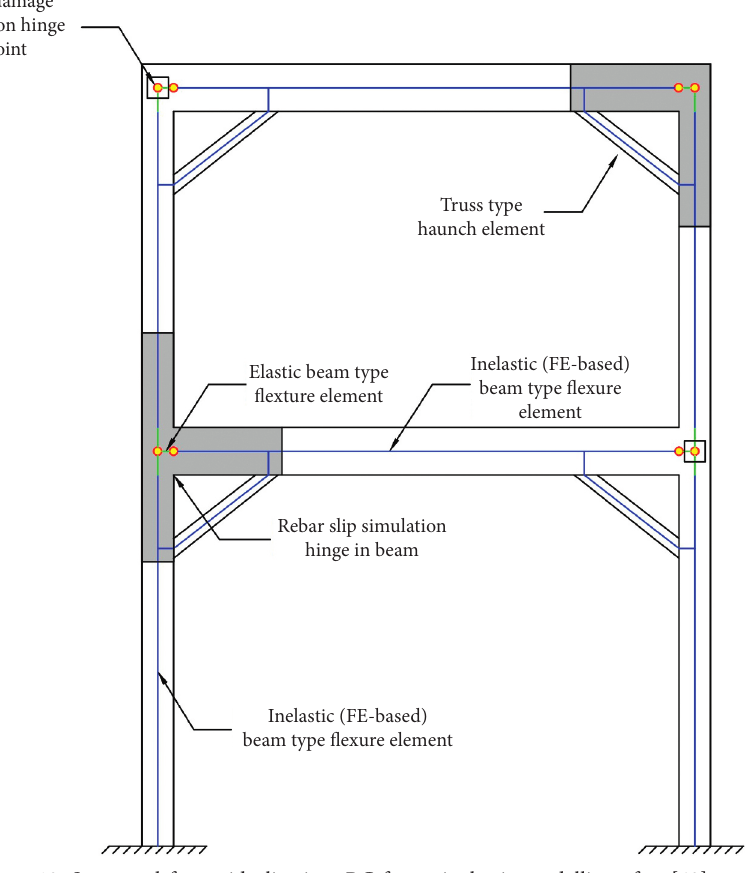
Figure 10: Structural frame idealization; RC frame inelastic modelling after